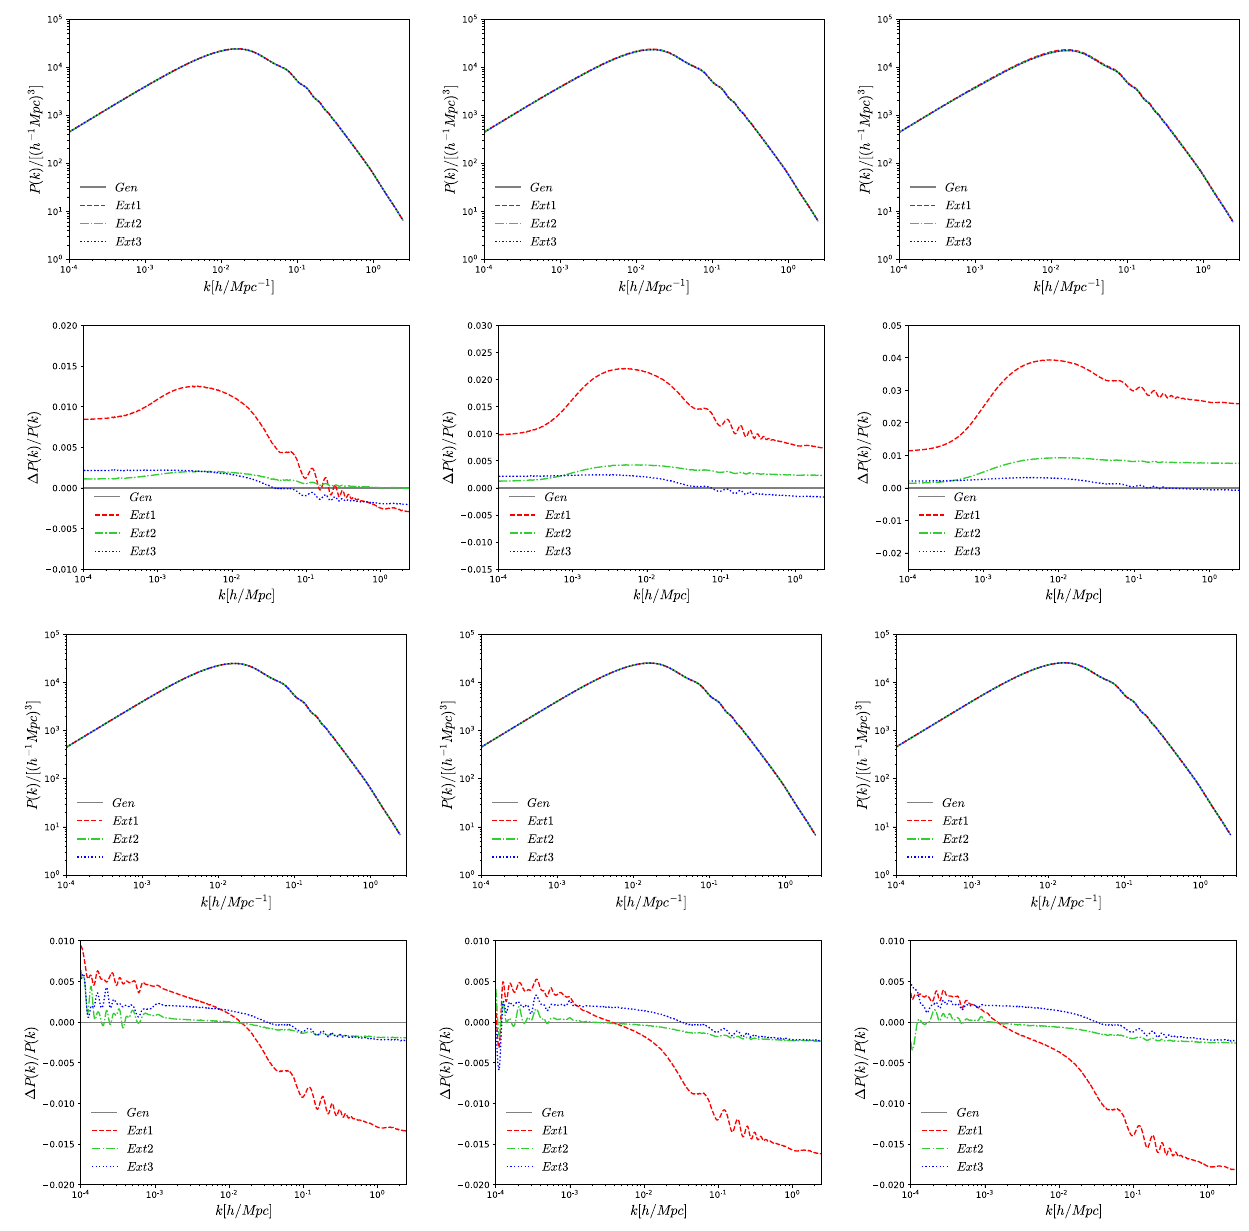
Fig. 12 We show the matter power spectra and the corresponding residual plots for the present dynamical dark energy parameterizations using various values of the w a parameter with a fixed w 0 = − 0 . 95. The plots in the first row present the matter power spectra and the plots in the second row present the corresponding residual plots. The plots from left to right in the first and second panels of this figure respectively